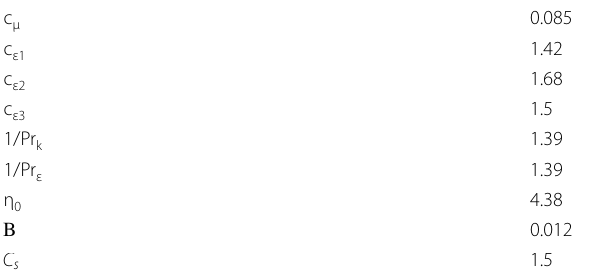
Table 6 Values of RNG k‑ε model constants